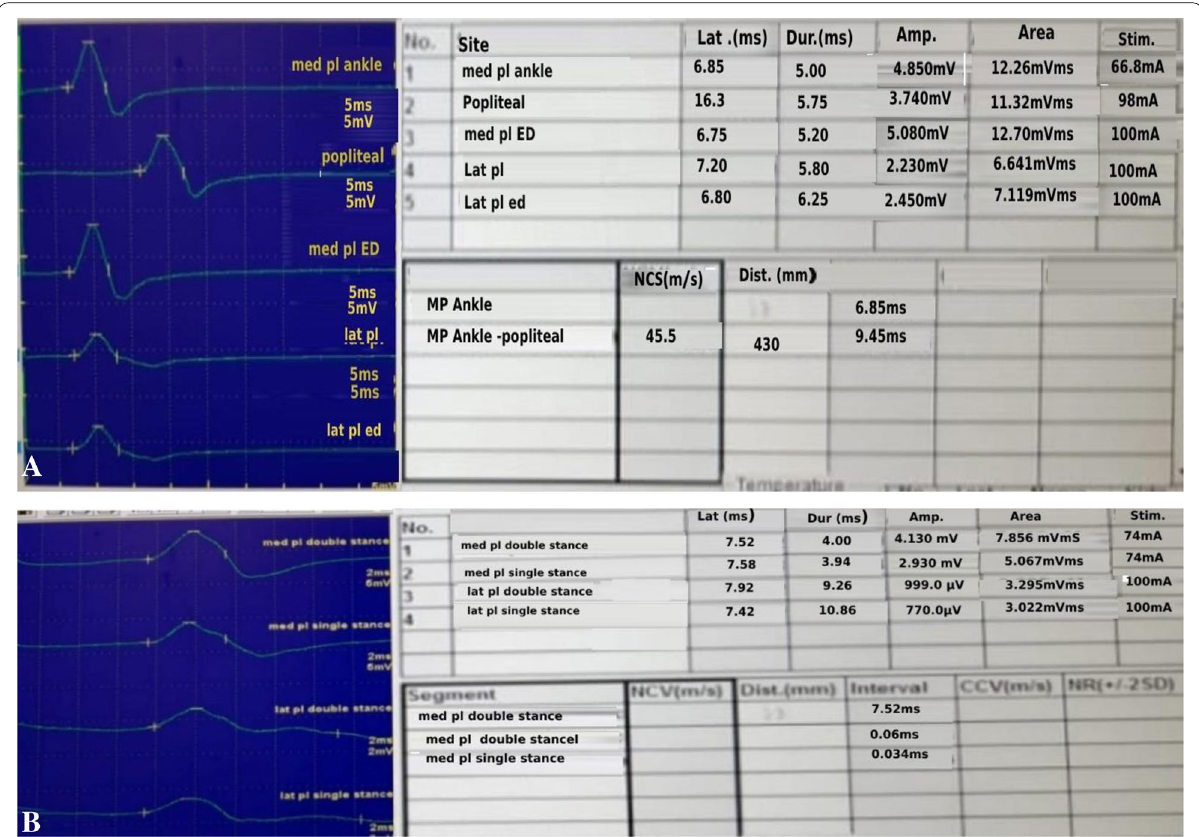
Fig. 5 NCSs of MP and LP nerves in a 20-year-old adult with tarsal coalition using routine NCSs and Novel tests (EDCT, DST, SST) showing delayed latency of MP and LP nerves with decreased amplitude of LP nerve using routine tests ( A ), which was confirmed by novel tests specially MP SST where not only more latency delay was noticed but also marked drop of the amplitude of M response ( B ). These findings highlight how the novel tests could confirm the diagnosis of TTS by exaggerating the mild affection seen on doing routine NCSs by biomechanically challenging the nerve using stance positions (DST and